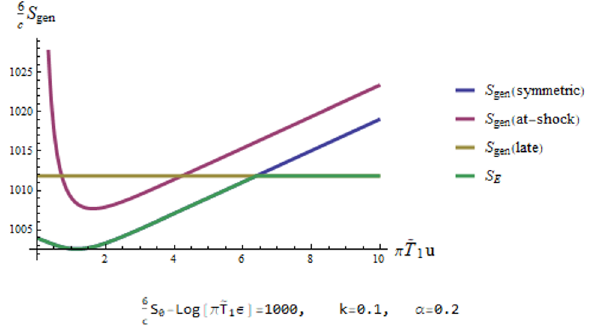
Figure 16. All the QESs. Dashed blue lines denote entanglement DOFs, and purple lines mark the location of QESs, and they are labelled by the value of 6 with the same generalised entropies aren’t actually degenerate, but our analysis is insufficient to distinguish them. AdS boundaries are as before at the far left/right of the figure above. We have defined the quantity k =